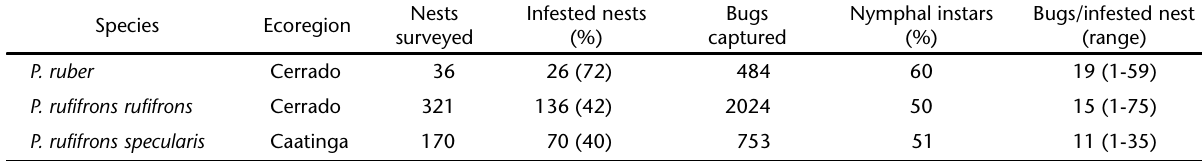
Table I. Entomological indices of P. tertius in thornbird nests in Brazilian Cerrado and Caatinga ecoregions.